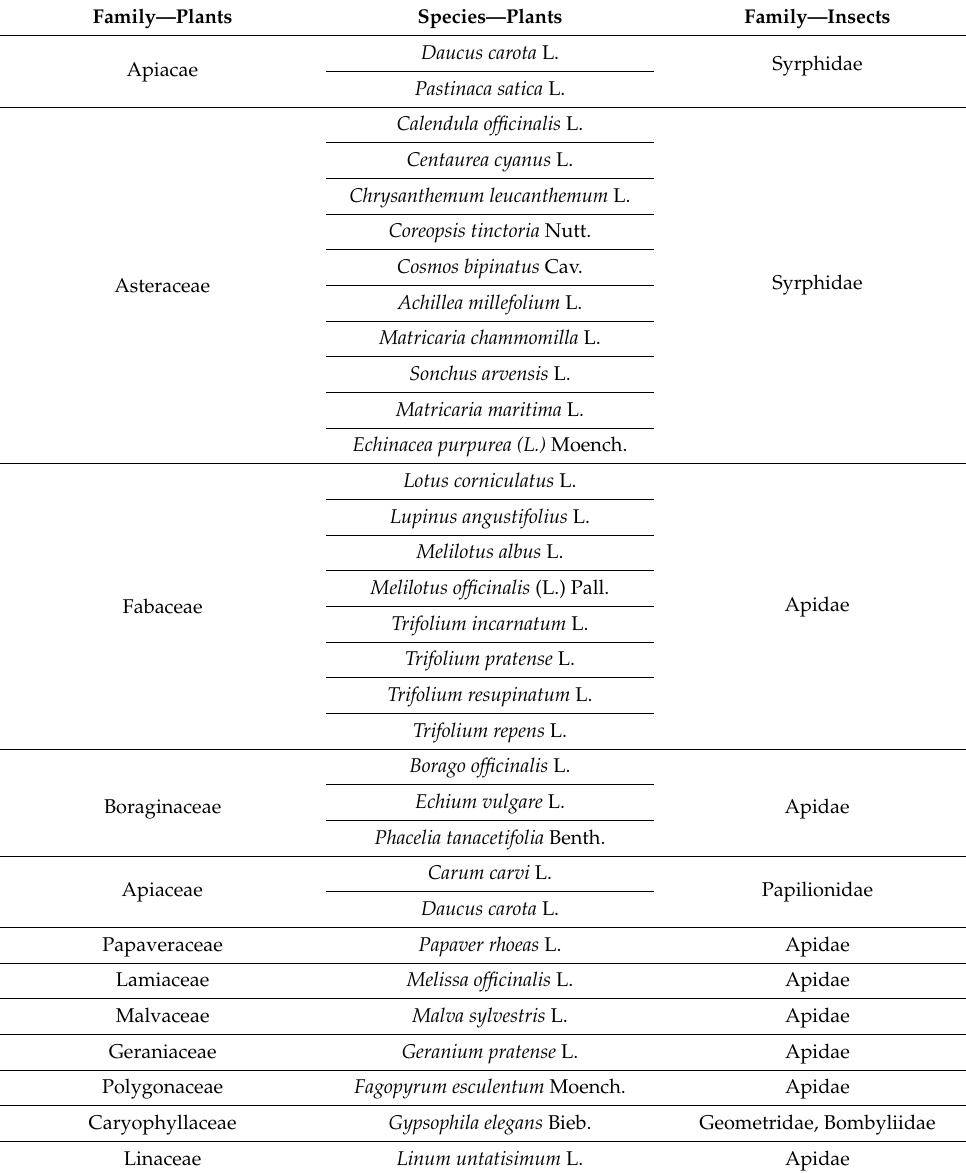
Table 1. Sample list of plants that can be used in flower strips and preferences of insect families in visiting plant species